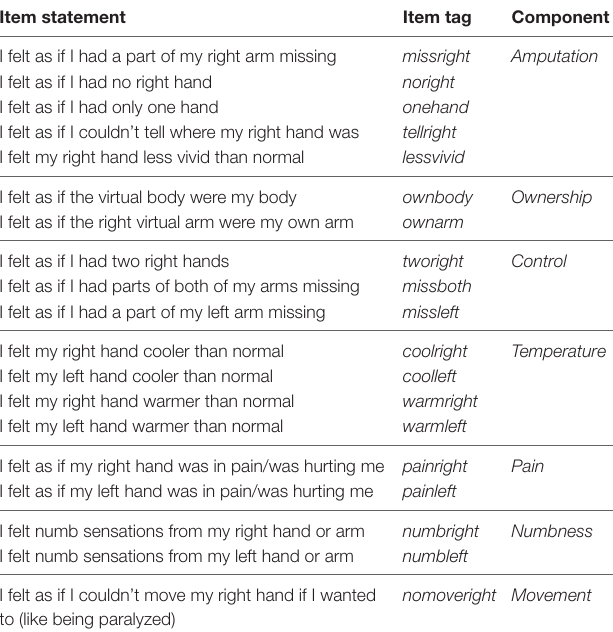
TABLE 2 | Statements related to the VR experience. TABLE 3 | Medians and interquartile ranges of the questionnaire responses for the Control and Amputation conditions.